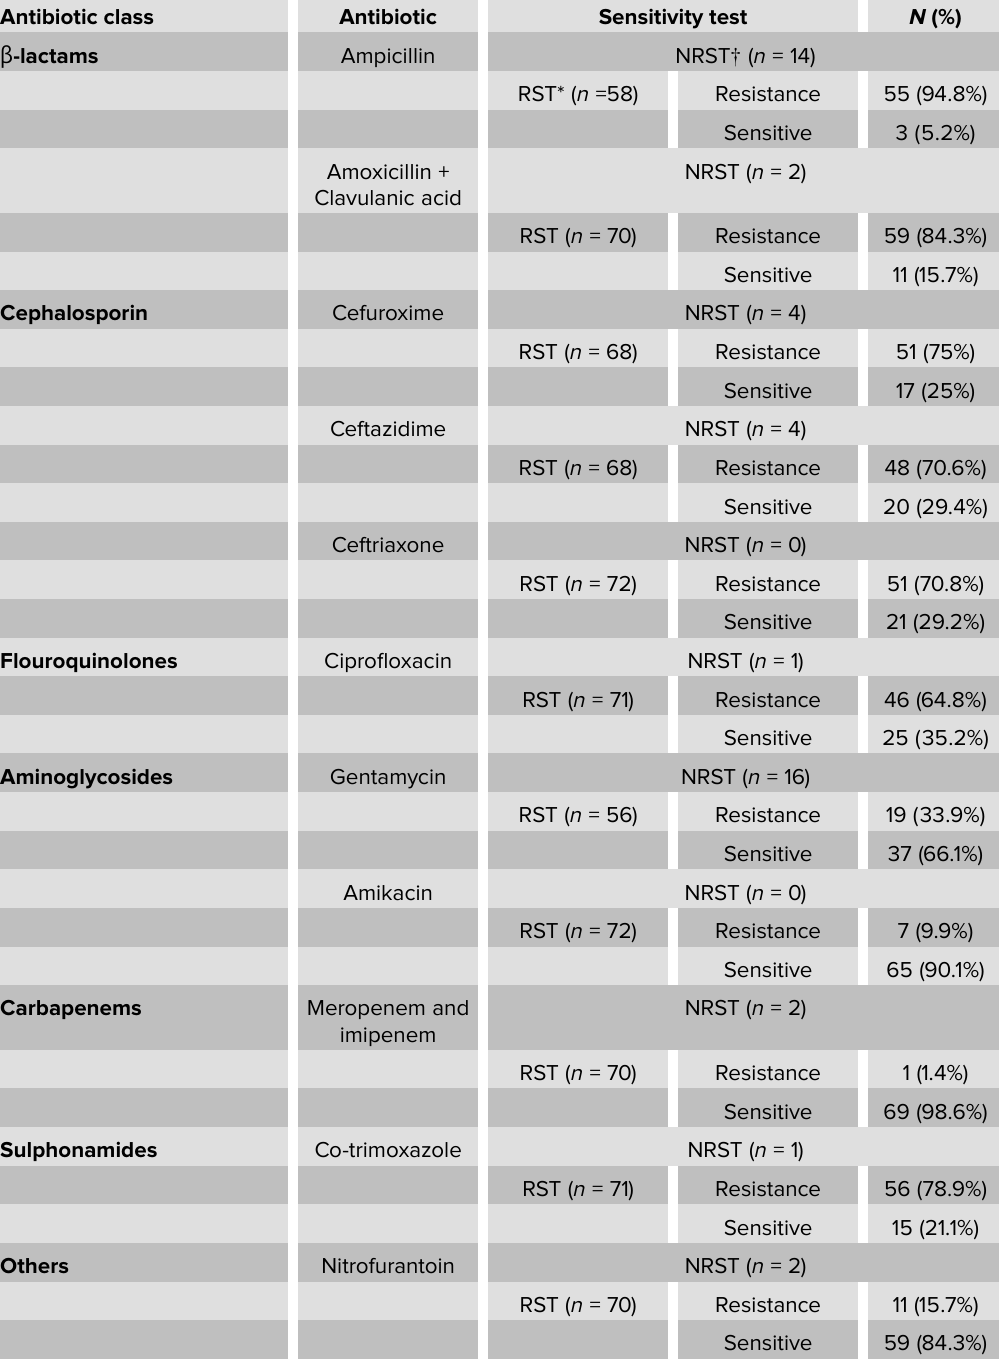
Table 3: Distribution of pediatric patients’ sample according to sensitivity pattern ( n = 72). Antibiotic